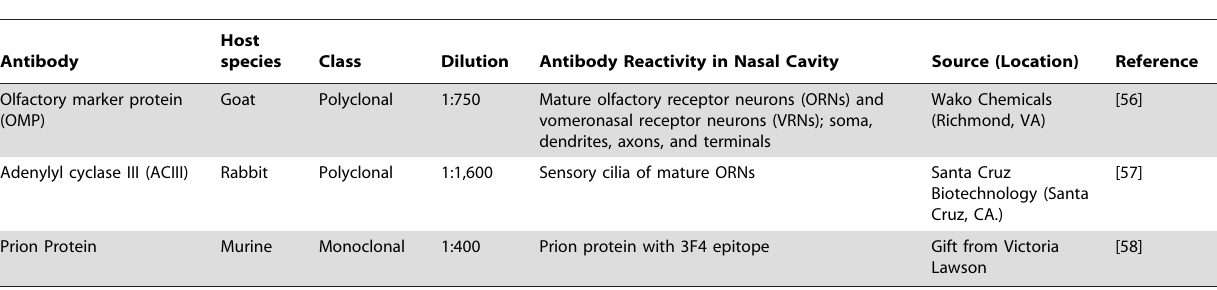
Table 4. Primary antibodies used to investigate HY TME infection in olfactory mucosa by laser scanning confocal microscopy.